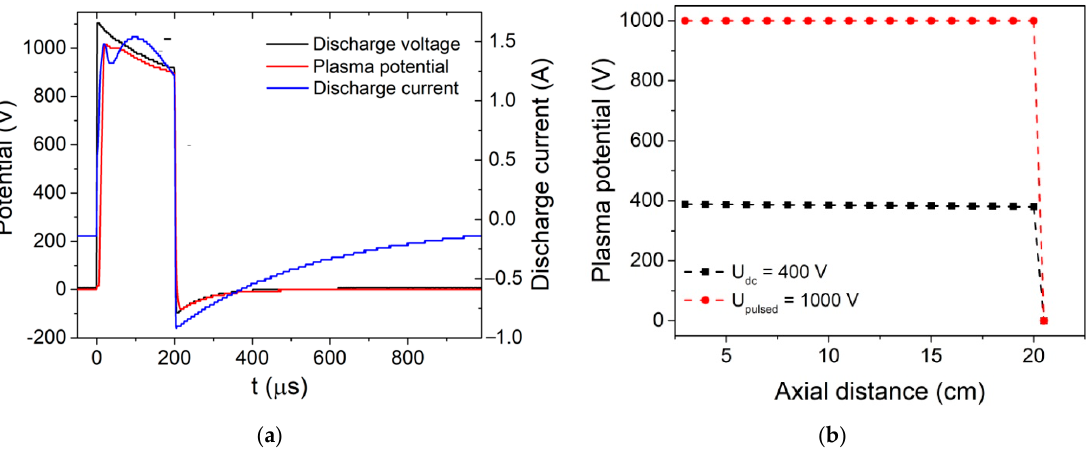
Figure 1. Temporal evolutions of ( a ) discharge voltage, discharge current and plasma potential measured during PTVA with discharge voltage U = 1 kV, pulse duration τ = 200 µs and repetition frequency ν = 1 kV. ( b ) Axial distribution of peak plasma potential measured between Wehnelt cylinder and port substrate during DC-TVA (U = 400 V, I = 300 mA) and PTVA discharges.